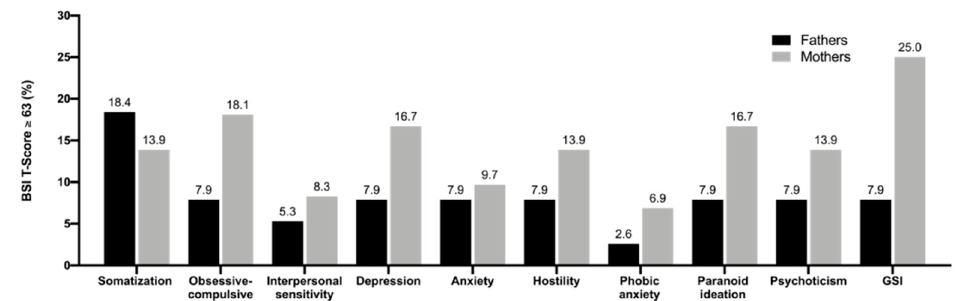
Figure 1. Percentage of mothers and fathers with clinically significant Brief Symptom Inventory (BSI) scores.